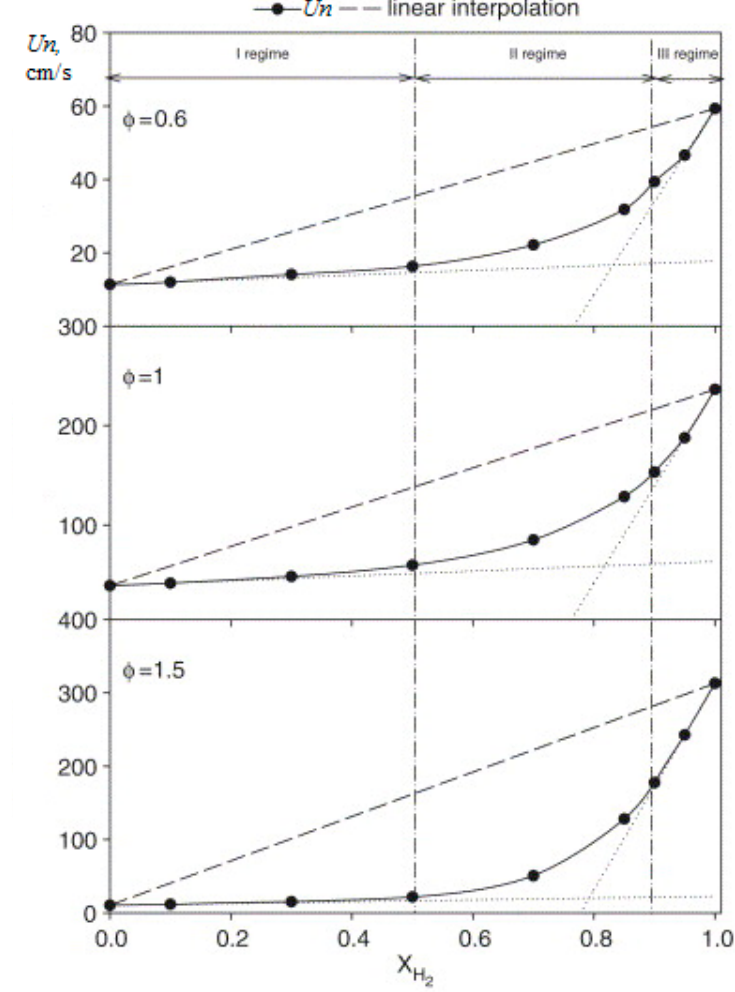
Figure 9. Dependence of the normal flame velocity Un of methane–hydrogen–air mixtures under normal conditions and various values of φ on the hydrogen concentration (---linear interpolation) (Adapted with permission from ref. [23], Copyright 2007, Elsevier.).